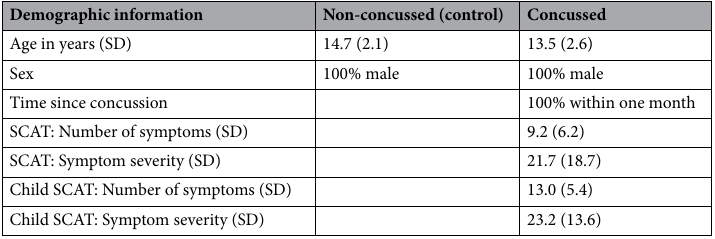
Table 1. Demographic information for the participants involved in this study. SD stands for standard